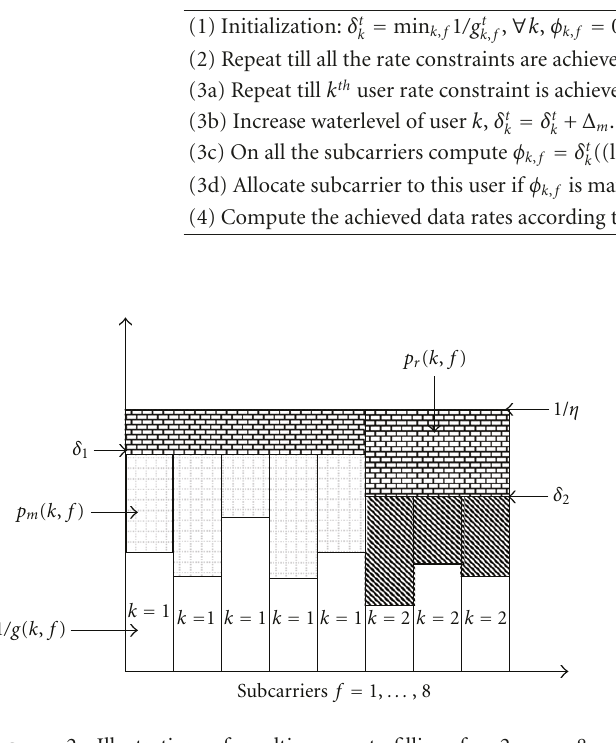
Table 2: Margin adaptive algorithm.